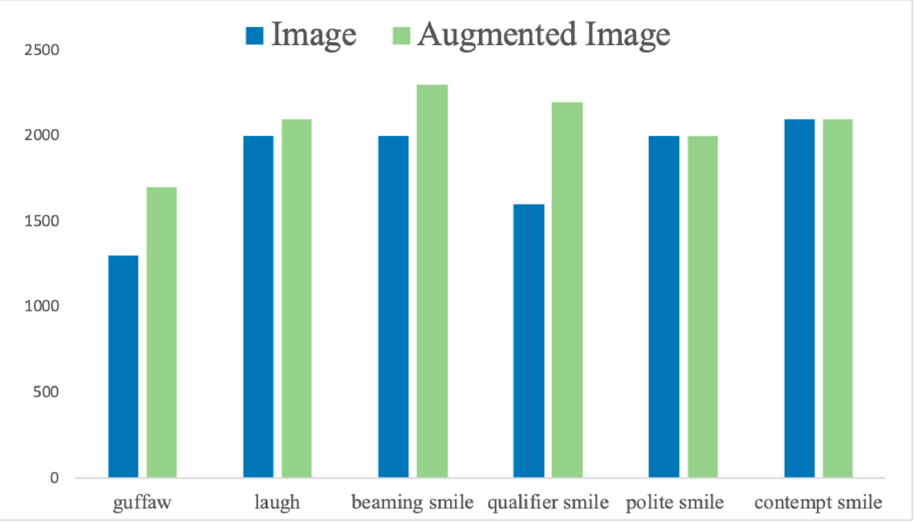
Figure 4. Data distribution over images and augmented image datasets for smile-emotions. Table 2. List of associated characteristics for Facial Expression Emotions.